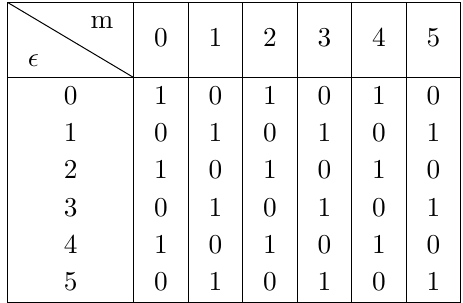
Figure 16 . New rule of both (cid:28) (cid:22) (cid:28) and 1(cid:22) (cid:28) on a disk. The (cid:3) is still a wildcard. The rule indicates that the upper box in the same column with the box added by 1(cid:22) (cid:28) is always unoccupied.